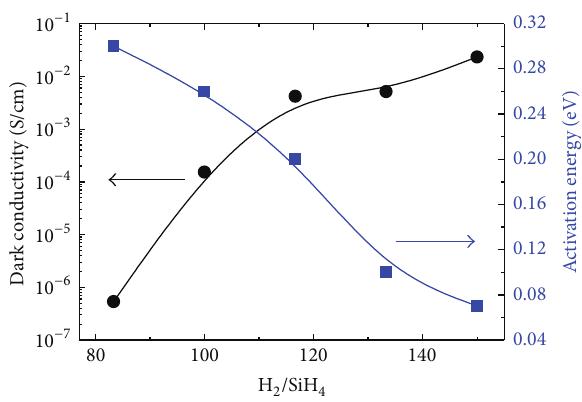
Figure 5: Dependence of the dark conductivity and activation energy on the H 2 /SiH 4 dilution for p- 𝜇 c-Si 1−𝑥 O 𝑥 :H films.